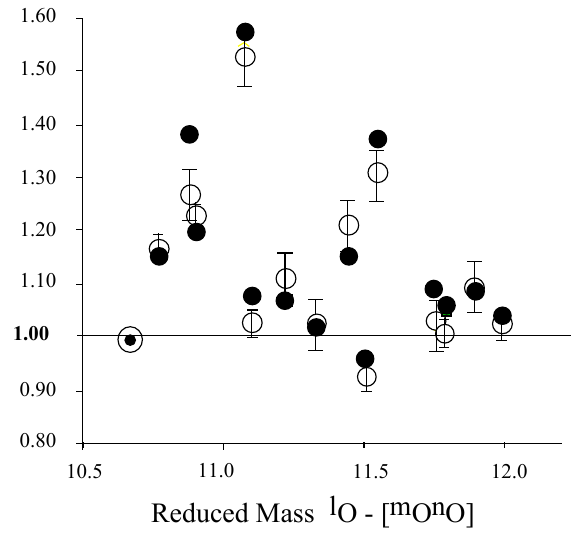
Figure 8 : F. Robert & C. Camy-Peyret in Ozone isotopic composition